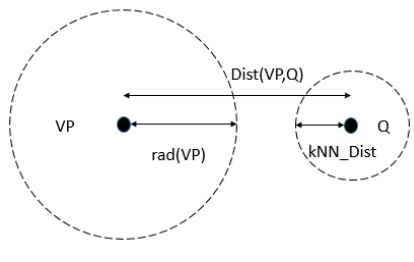
Figure 6. Pruning the left subtree.